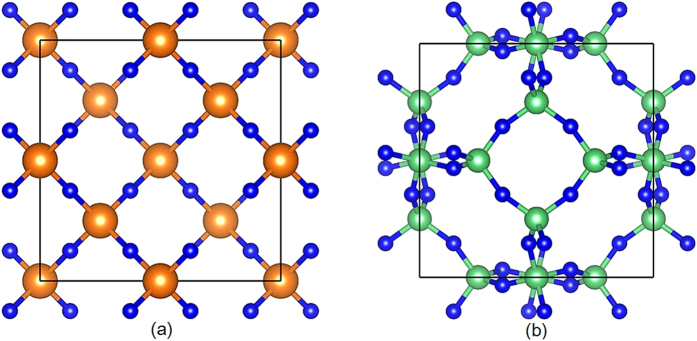
Crystal structures of MgF2 and BeF2.(a)  MgF2 constructed from MgF4 coordination polyhedra; (b)  BeF2 constructed from BeF4 coordination polyhedra. Blue spheres denote F atoms, brown spheres denote Mg atoms, and green spheres denote Be atoms.